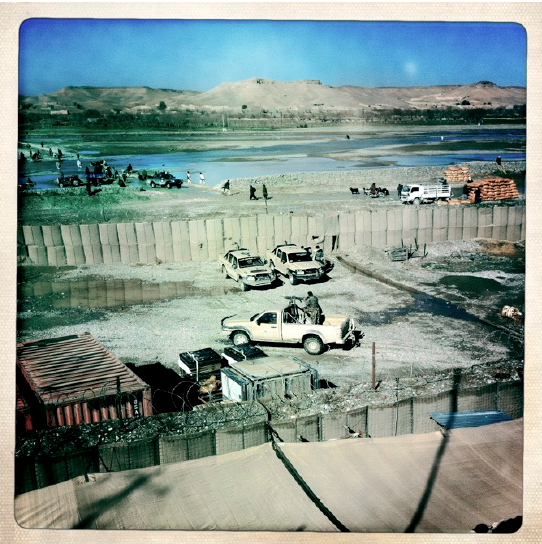
Figure 8. HESCO base. Source: created by Rita Leistner (used with photographer’s permission). 6. At the End